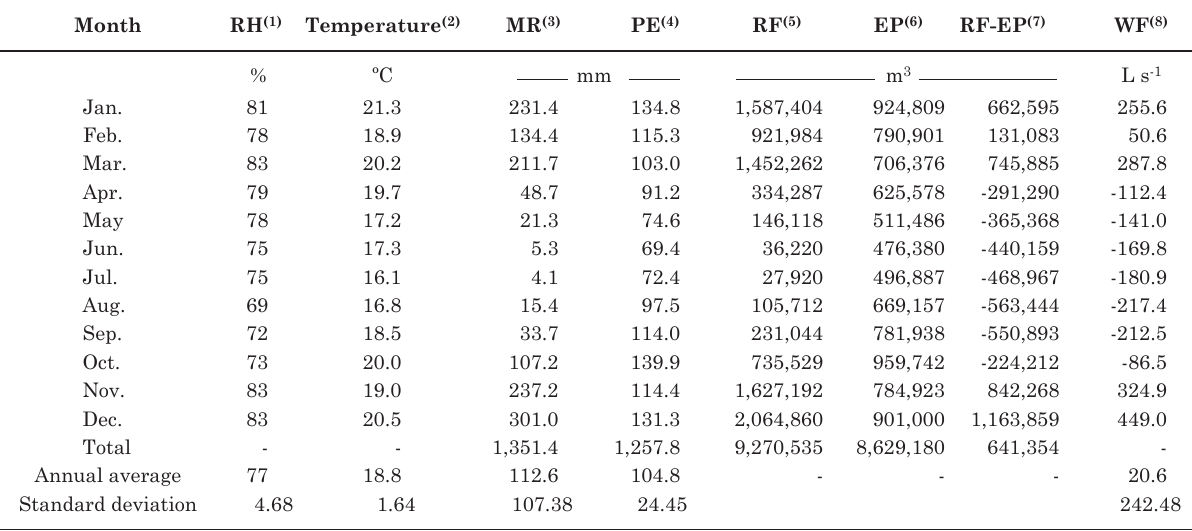
table 4. average monthly meteorological data of the inflow area of peatland in the environmental protection area of pau-de-fruta